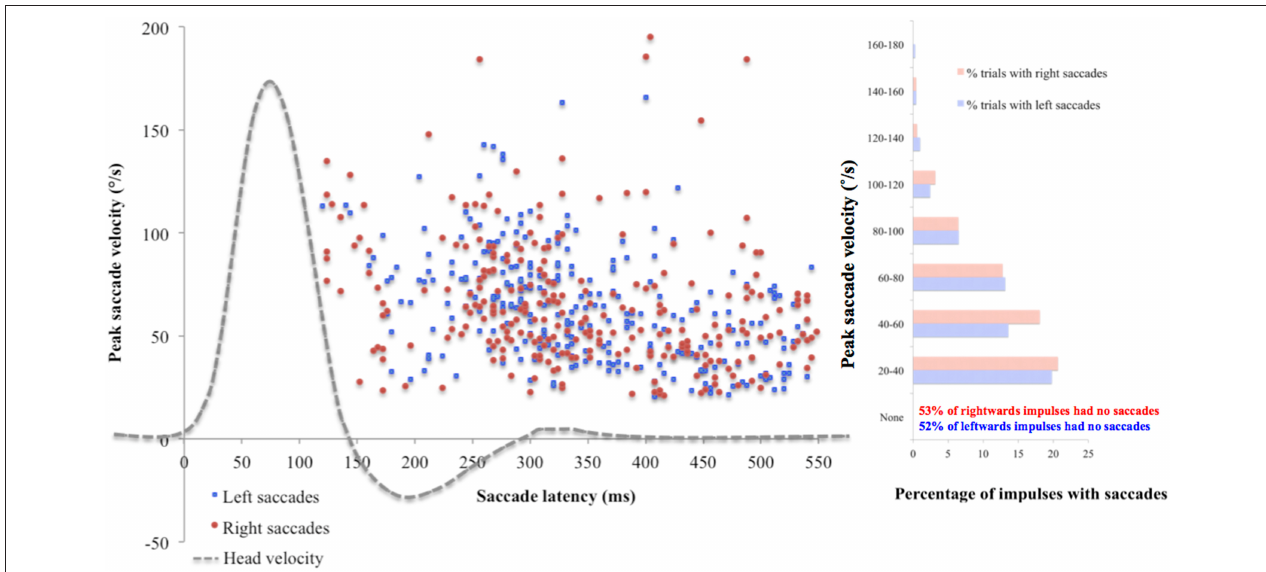
FIGURE 1 | Saccade peak velocity and latency. Positive saccades produced by the whole cohort on the first trial using standard target size 4. The majority of saccades were overt (occurring after the end of the head impulse). Across the cohort, mean incidence was 5.70 (SD 4.64) saccades for left ears and 5.81 (SD 4.41) saccades for right ears, mean peak velocity was 62.94 ◦ /s (SD 24.63) for left ears and 58.63 ◦ /s (SD 24.63) for right ears, and mean latency was 364.38ms (SD 75.46) for left ears and 379.22ms (SD 69.05) for right ears. There were no statistically significant differences found between ears on any saccade metric (incidence: U = 1114, p = 0.78; peak velocity: U = 919, p = 0.45; latency: t (88) = − 0.97, p = 0.33).